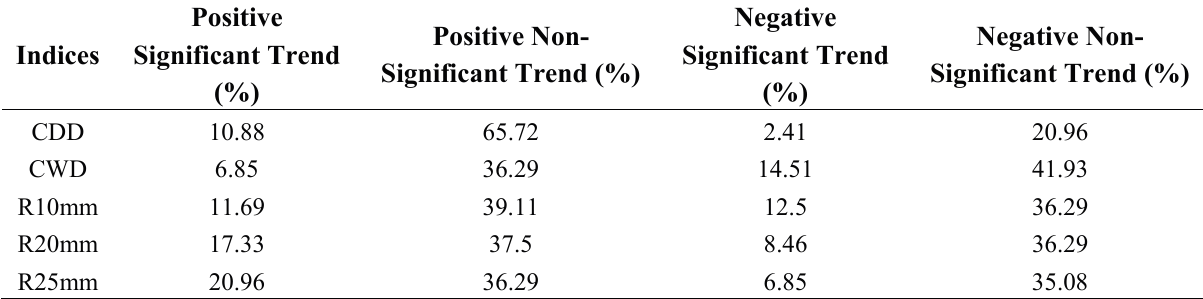
Figure 9. The most significant negative trend with a slope of − 0.3809 ( left ) and the most significant positive trend with a slope of 0.2318 ( right ) of the R25mm index. Table 2. The percentage of significant and non-significant trends of frequency